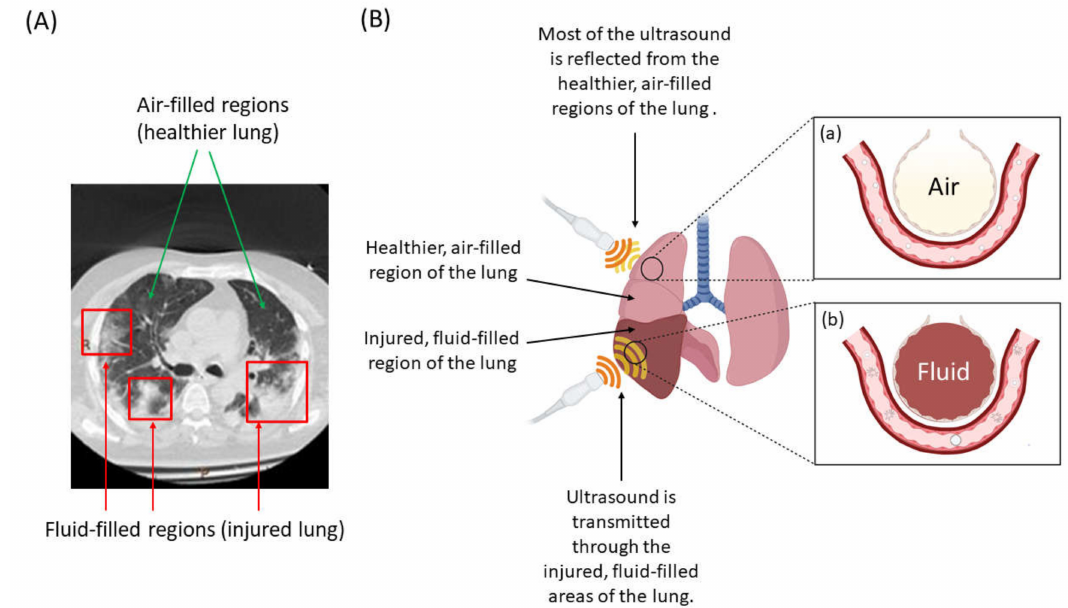
Figure 3. Courtesy of Laurent J. Brochard, St. Michael’s Hospital, Toronto( A ) Lung CT scan (cross-sectional view) from a patient with ARDS showing heterogenous distribution of injured, fluid-filled regions of the lung ( B ) USMB treatment of the lung targets the most injured and edematous regions. ( a ) Ultrasound energy is unable to penetrate the relatively healthy aerated sections of the lung, reflecting instead. Microbubbles in this region flow through the capillaries unaffected by the ultrasound waves. ( b ) Ultrasound energy is able to penetrate when the alveoli are filled with fluid in edematous or de-aerated regions, sonicating the microbubbles. Cavitation of the microbubbles is induced, resulting in cellular uptake of therapeutic cargo preferentially in the most injured area of the lungs. Created with